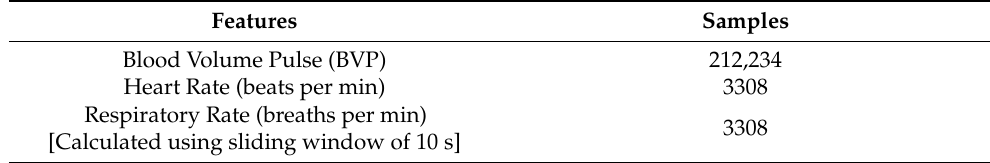
Table 3. The average number of entries (per participant) .